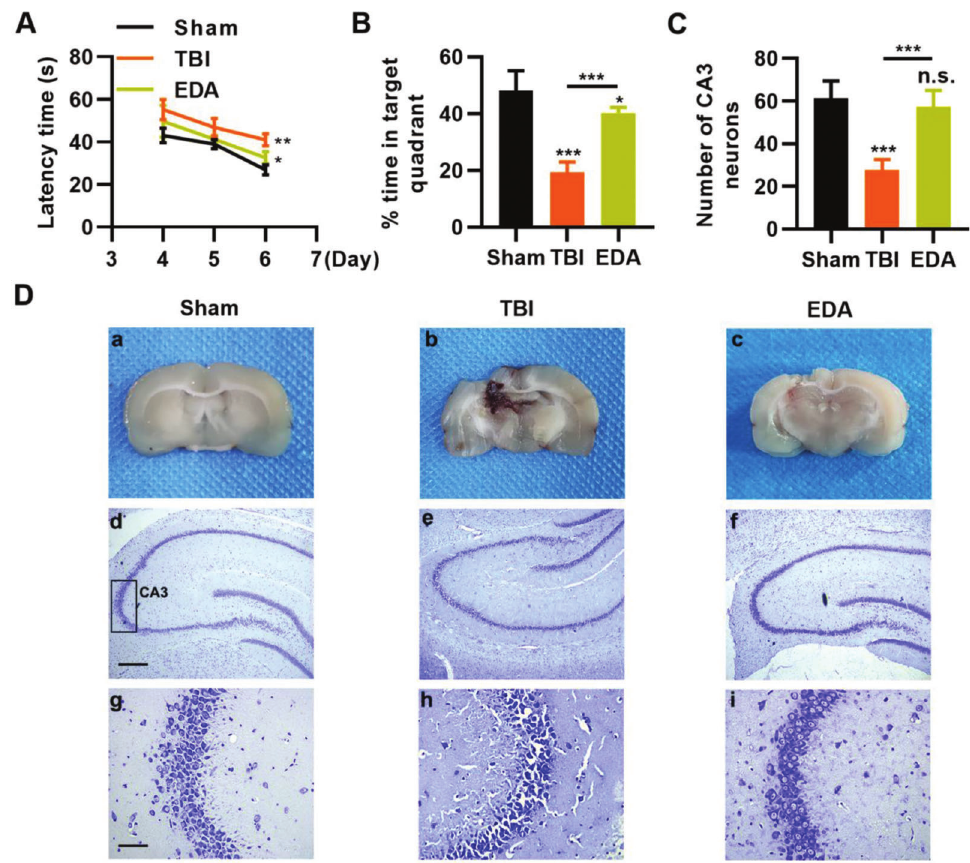
Figure 4 - Edaravone (EDA) improves the ability of rats in spatial learning memory. A, Observation of Morris water maze indicated that EDA shortened the escape latency of traumatic brain injury (TBI) rats; B, EDA prolonged the percentage of time of TBI rats spent in the targeted quadrant. * p o 0.05, ** p o 0.01, *** p o 0.001. Chi-squared test (A), Mann–Whitney U test